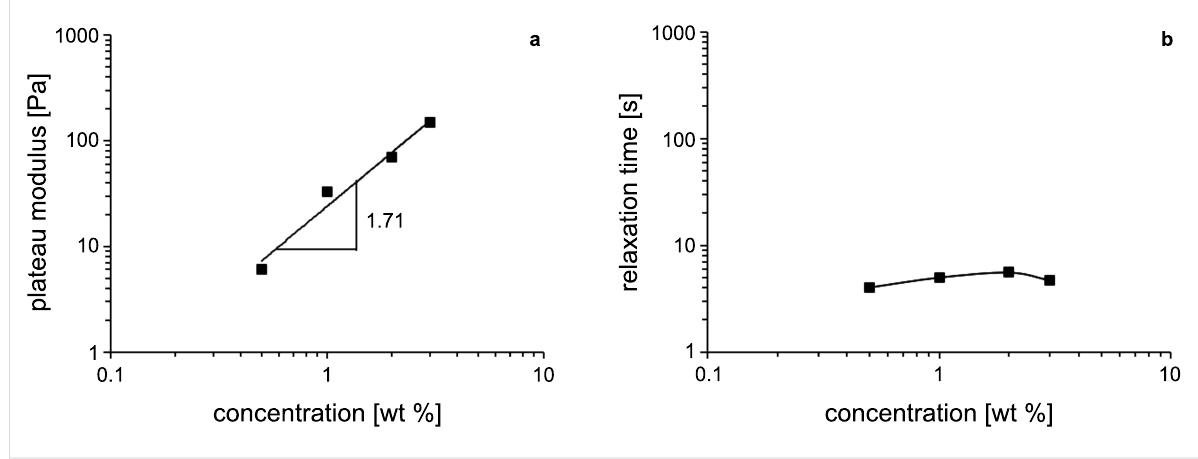
Figure 6: Double logarithmic plot of (a) the plateau modulus G 0 and (b) the relaxation time τ R against the concentration of 2 in toluene at 15 °C.